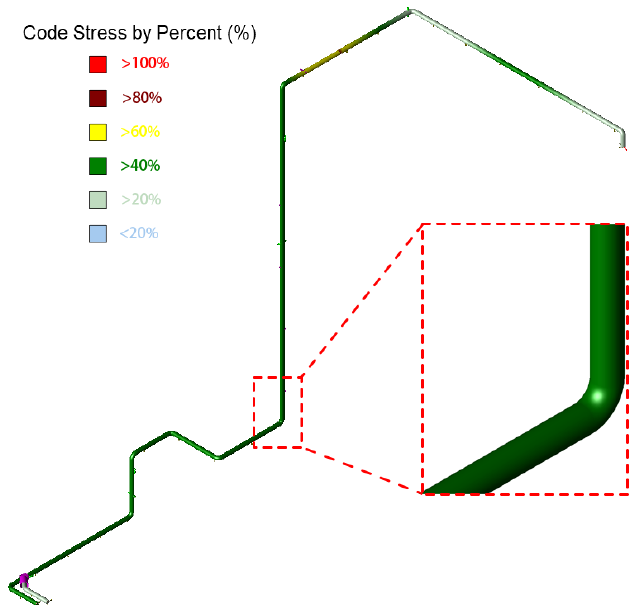
Figure 6. Stress distribution of the main steam pipeline system in operation.